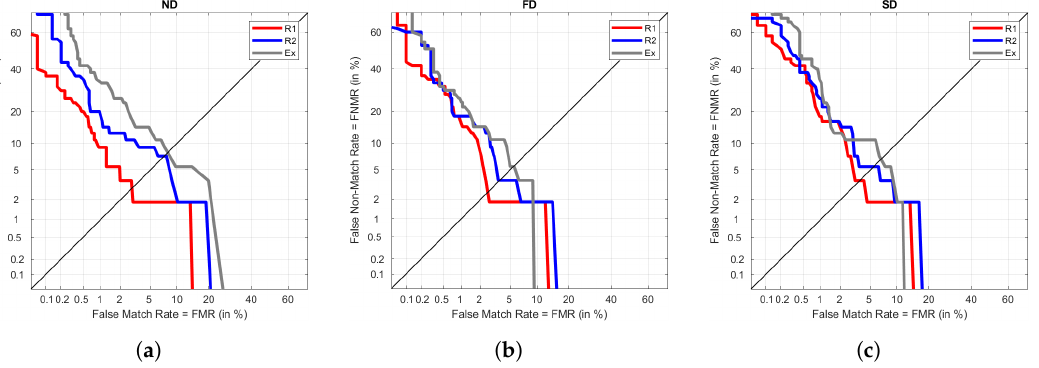
Figure 8. Results for every test set using ( a ) ND, ( b ) FD, and ( c ) SD signals with 50% of S as training.